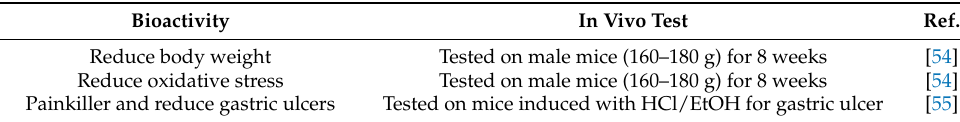
Table 1. The bioactivity studies of sacran in food